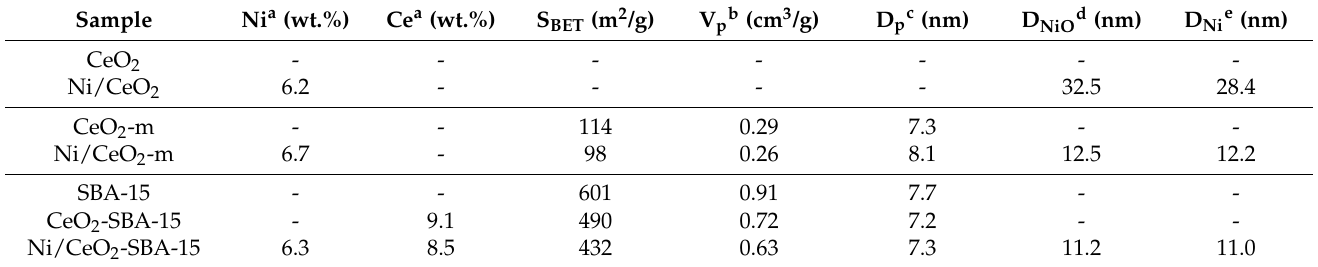
Table 1. Physicochemical properties of synthesized supports and